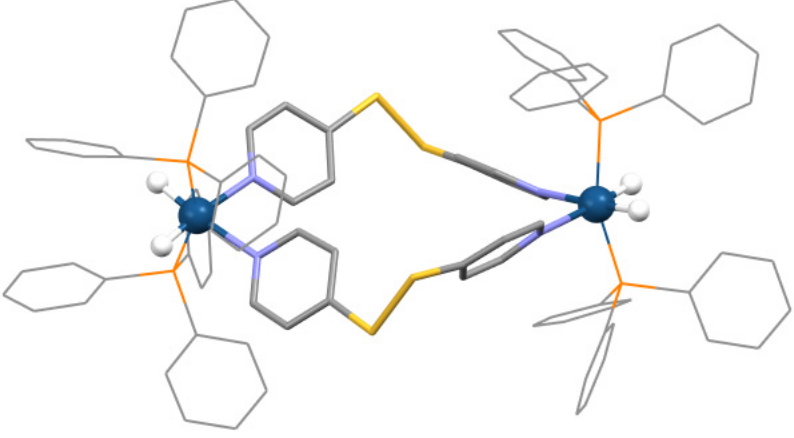
Figure 5. Molecular structure of the chiral M left-handed M form of dtdp in the centrosymmetric crystal